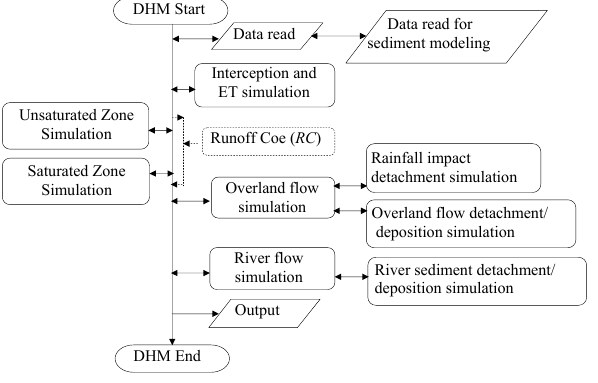
Fig. 1. Process-based approach of watershed sediment dynamics (after Foster, 1982).